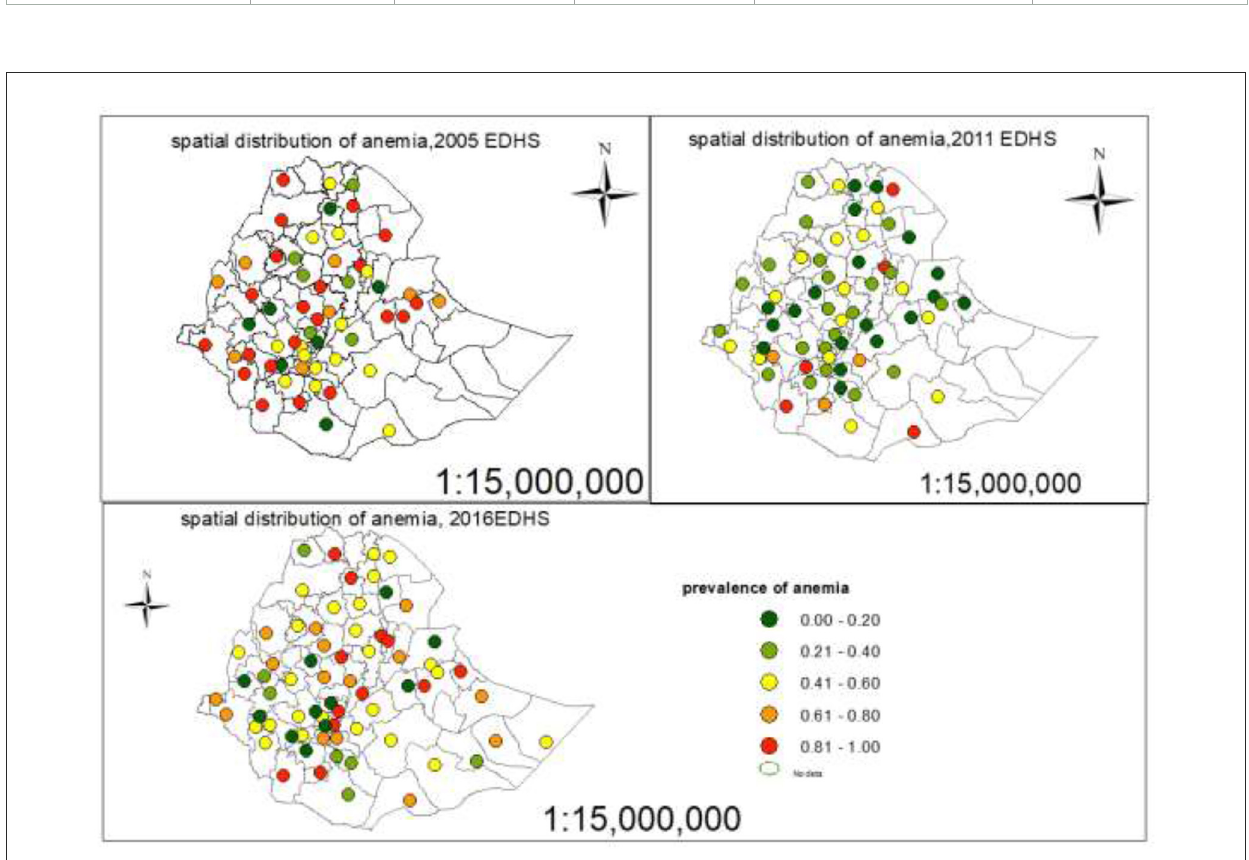
FIGURE5 Spatial distribution of anemia on pregnant women in Ethiopian administrative zones.